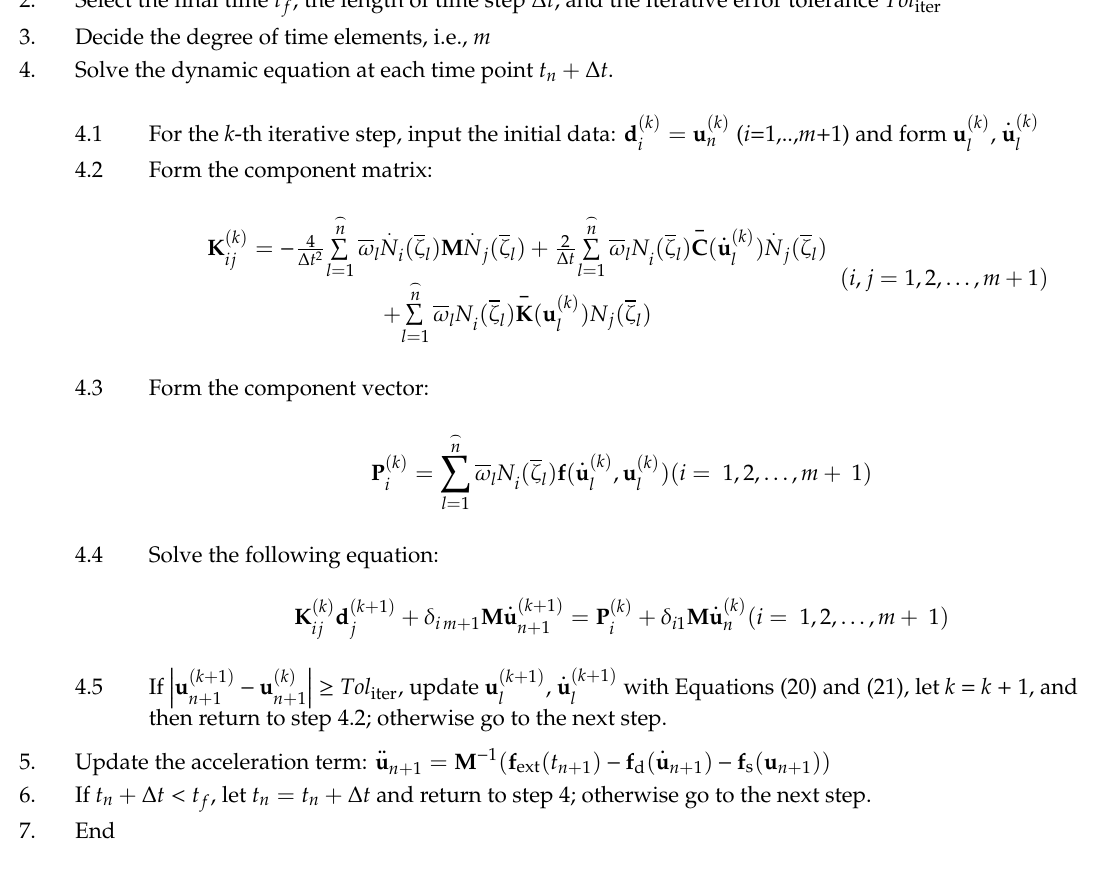
Algorithm 1 The proposed step-by-step time integration algorithm based on the Galerkin finite element method (FEM)